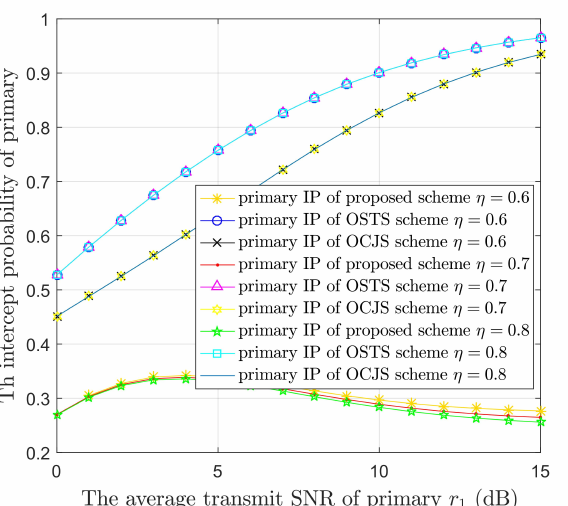
Figure 6. The IPs of the PUs versus the average transmit SNR of primary ( r 1 ) in the three protocols with different energy transfer efficiency ( η )